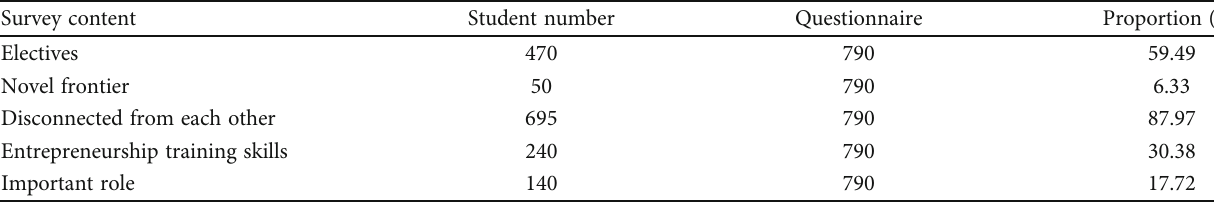
Table 2: Teaching of innovation and entrepreneurship education for college students.